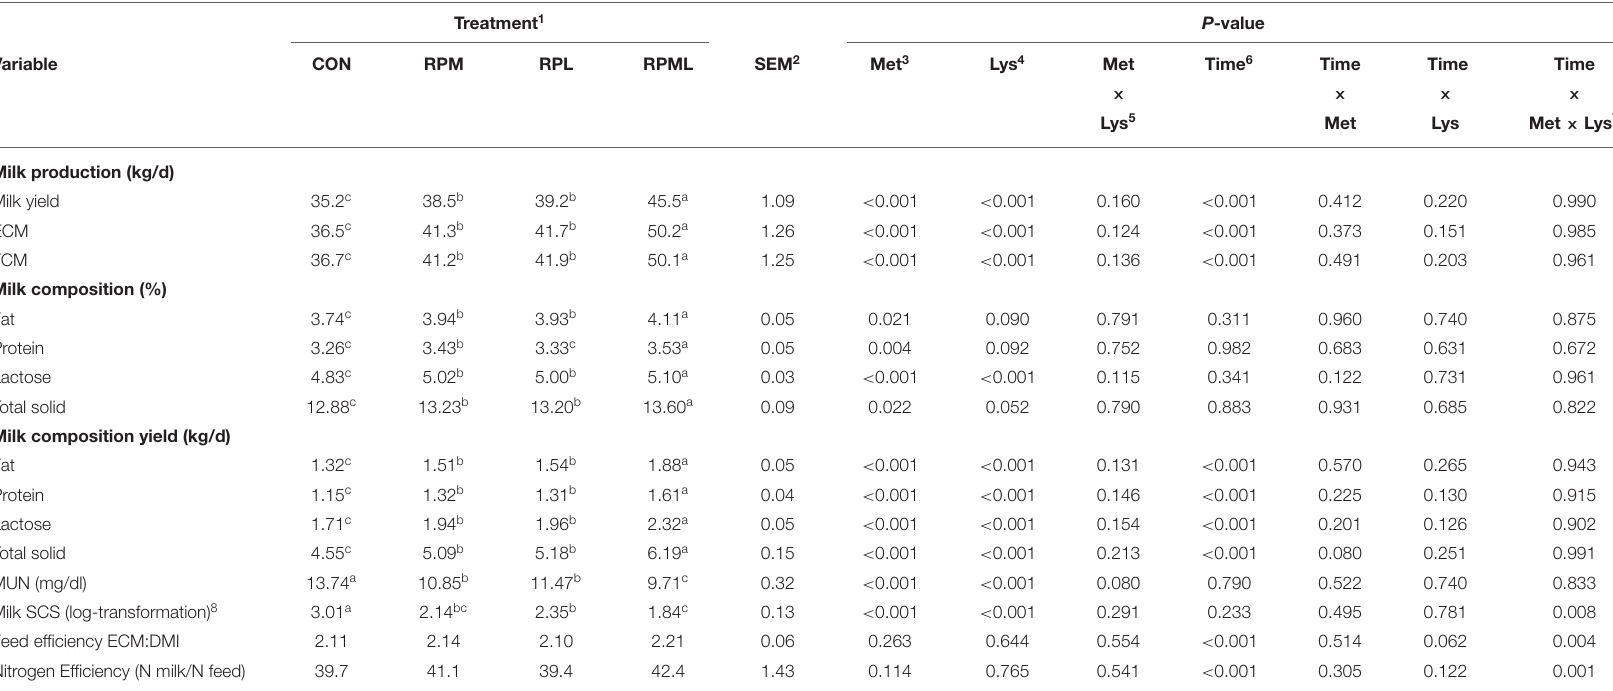
TABLE 5 | Effect of supplementation of ruminally protected Met and Lys on milk yield and composition during 3 wk post-calving in Holstein dairy